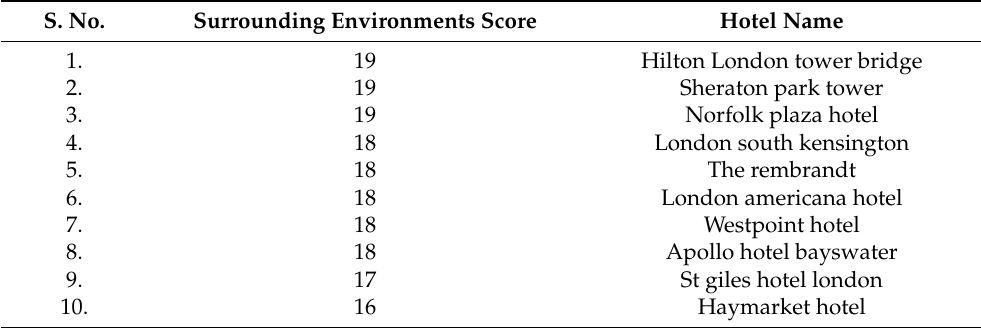
Table 13. Top-10 recommended hotels for the 875 Hotels of TripAdvisor based on surround- ing environments. S. No.